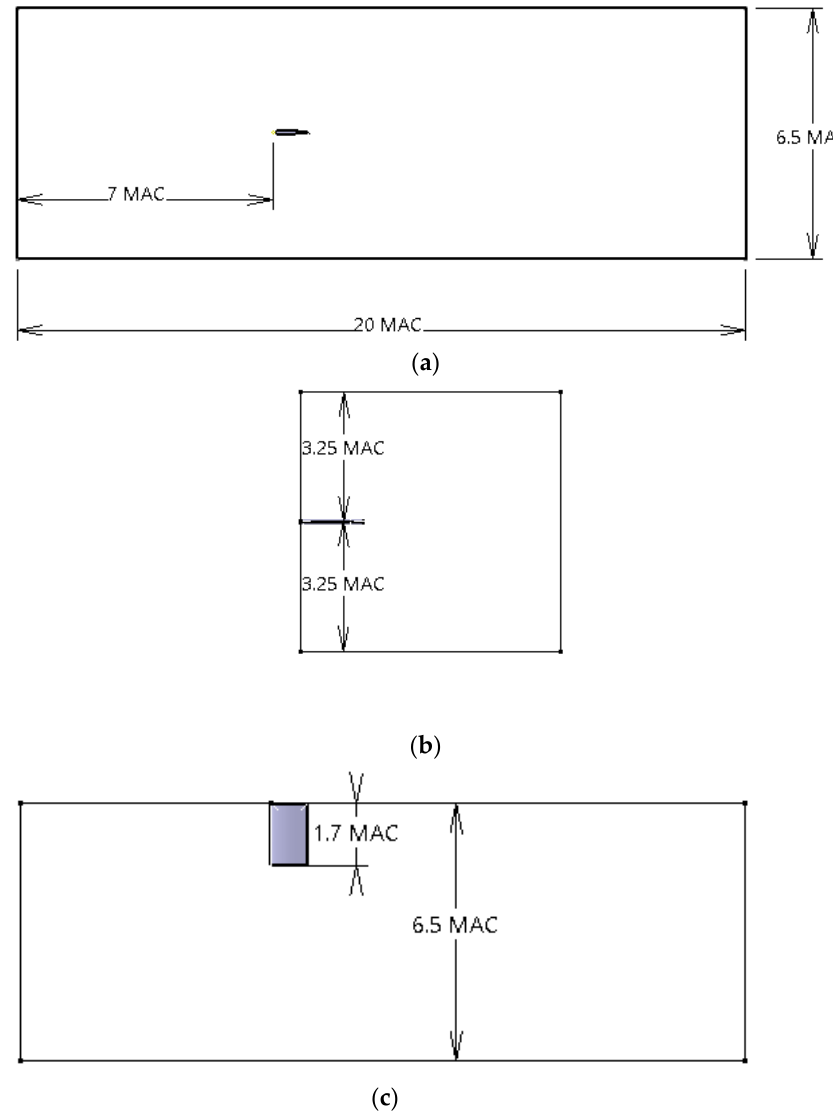
Figure 2. Computational domain: ( a ) left side view; ( b ) front view; ( c ) top view.